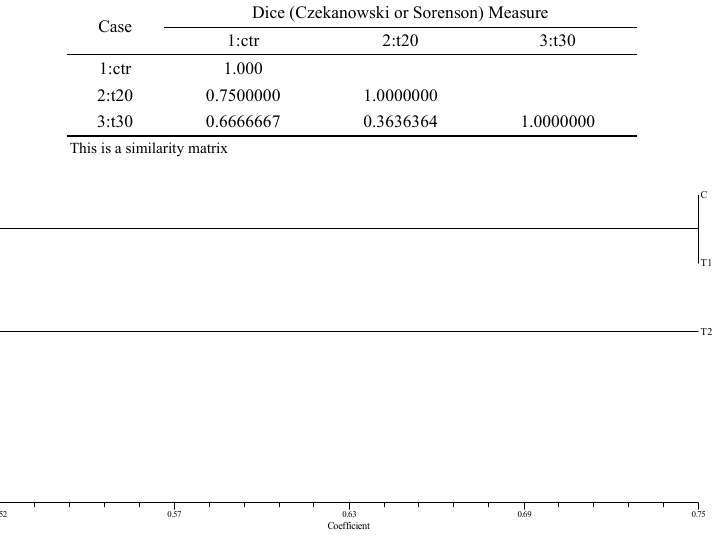
Fig. 7: Dendrogram obtained from analysis based on a rapid test using the UPGEMA method by NTSYS-PC Table 11: Similarity matrix for nisin, CuO, and CuO NPs conjugated with nisin at the same concentration of 30μg/mL Case